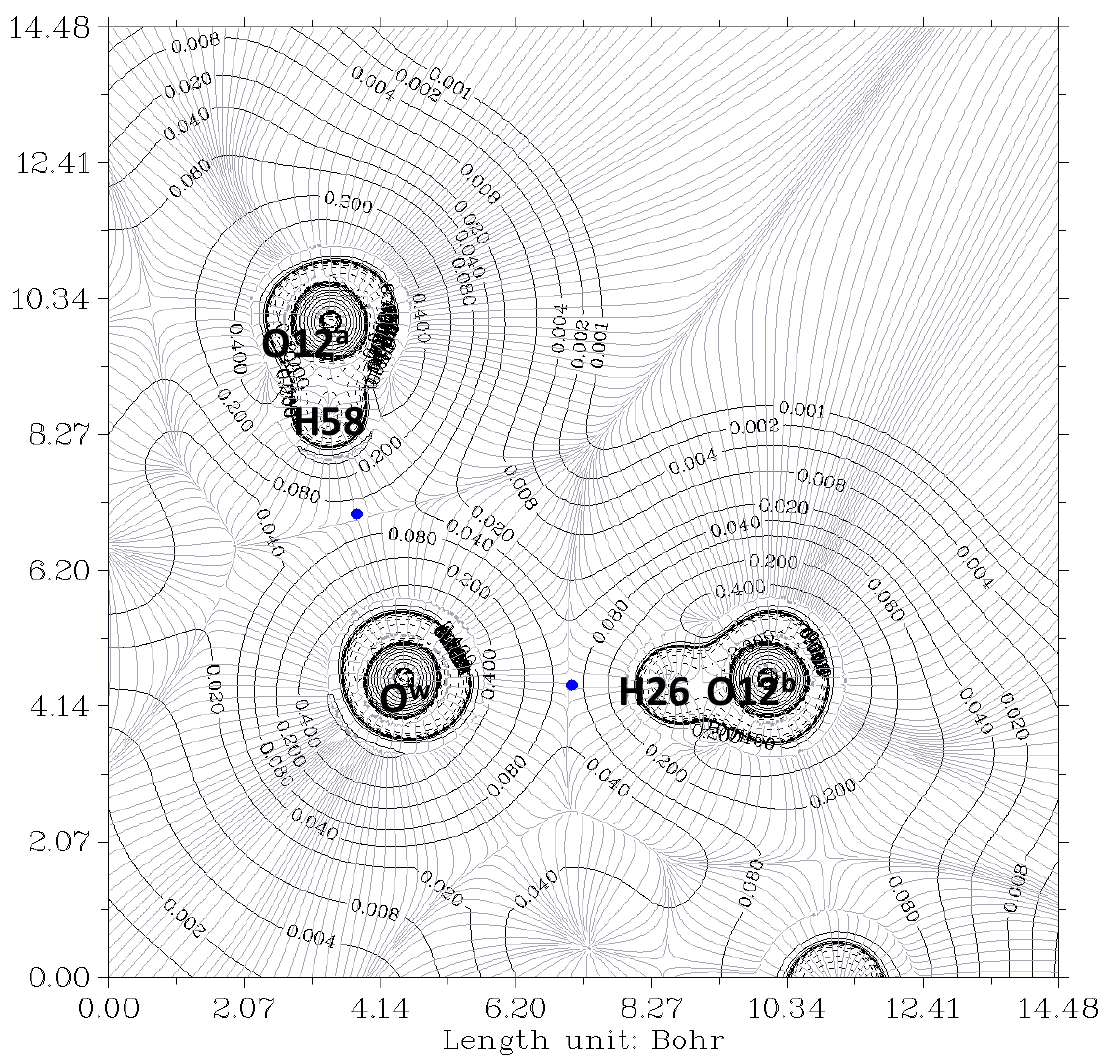
Figure 4. The electron density contour of the O 12a -H ... O w -H ... O 7a //O 12b -H ... O w -H ... O 7b complex (thin black lines) and BCP (3,-1) (blue dots). The plane is defined by the O 12a , O 12b , and O w oxygen atoms of the bile acid residues and water, respectively. Thin gray lines correspond to the gradient of the electron density.